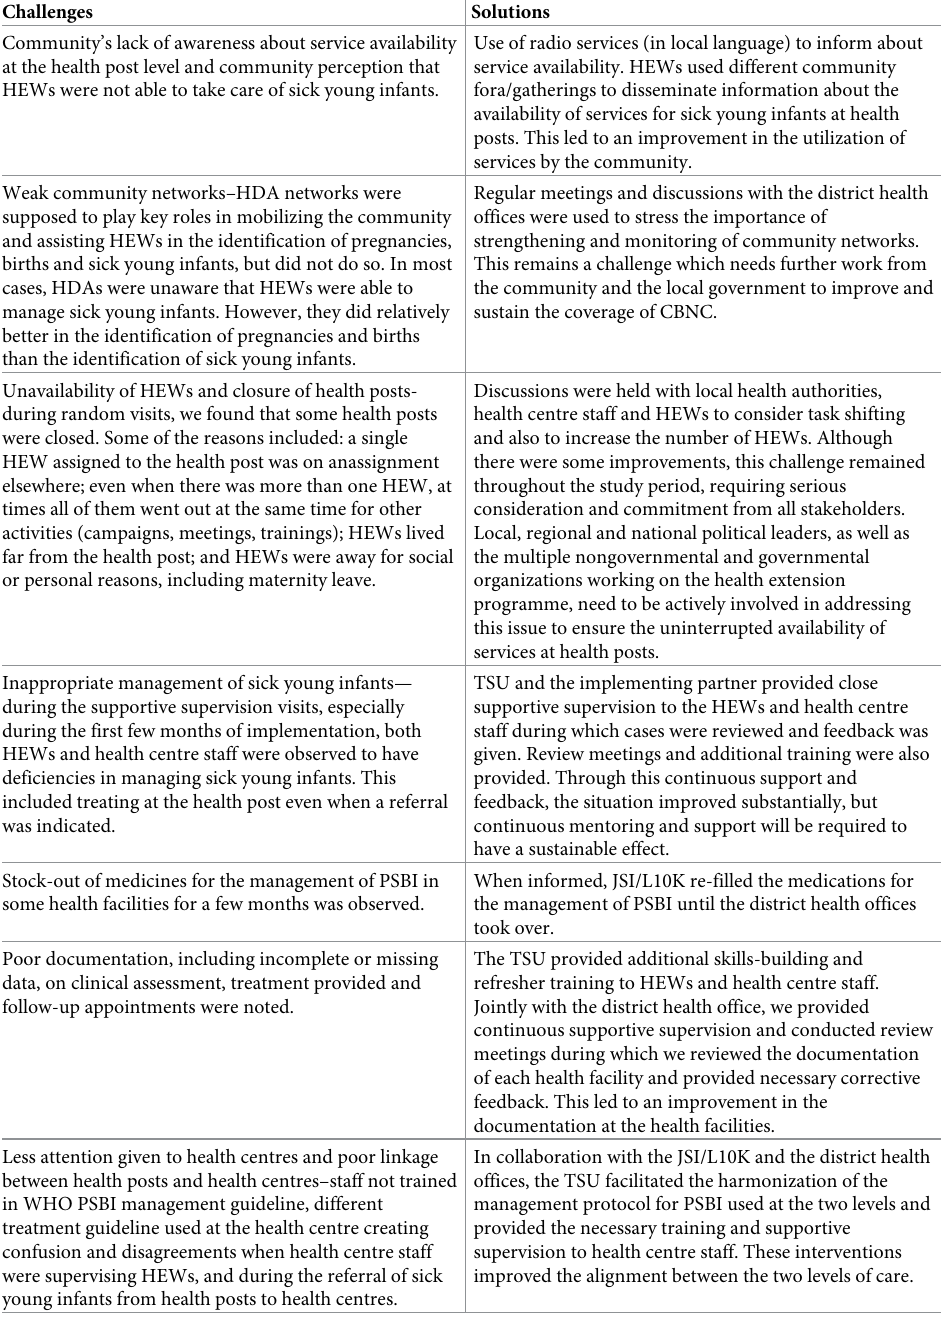
Table 4. Challenges faced during implementation of PSBI intervention and